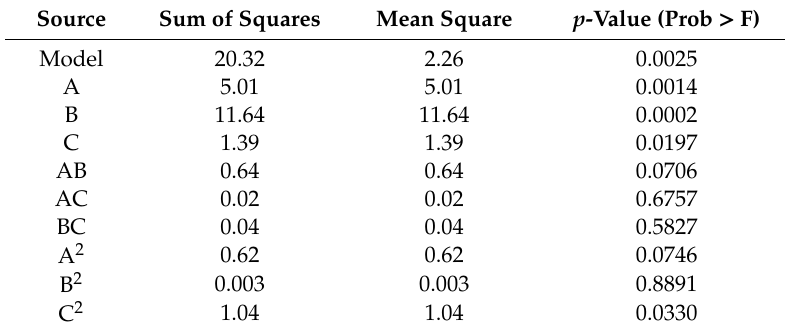
Table 4. ANOVA results for microparticle production of ethenzamide through